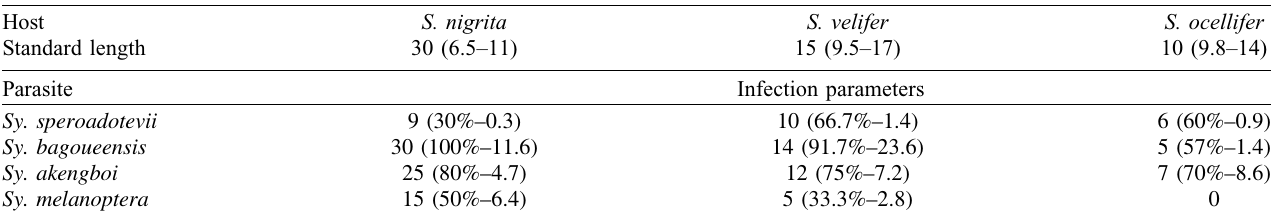
Table 1. The four species of Synodontella ( Sy .) encountered on the three species of Synodontis ( S .) examined from the River Bagoué, Côte d ’ Ivoire. Infection parameters given as number of parasites per host species followed by prevalence and mean intensity in parentheses; host standard length given as mean followed by min (cid:2) max, in cm. S.